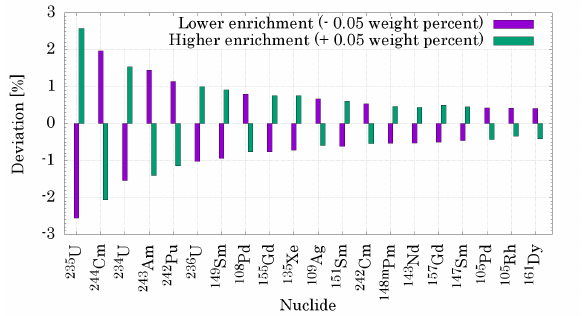
Figure 11. Effect of change in cladding radius